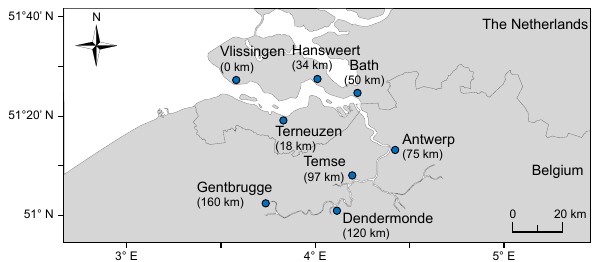
Figure 10. The Scheldt River